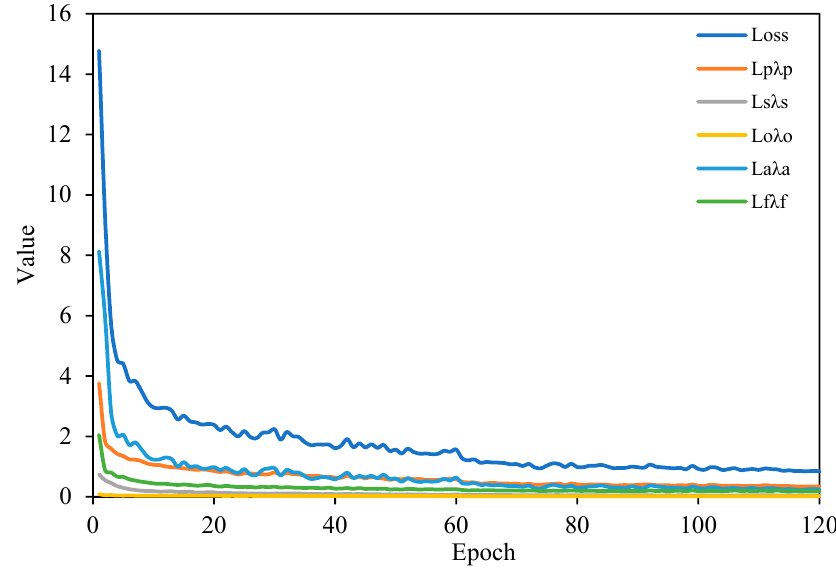
Figure 11. Variation of loss during training on the SSDD dataset.